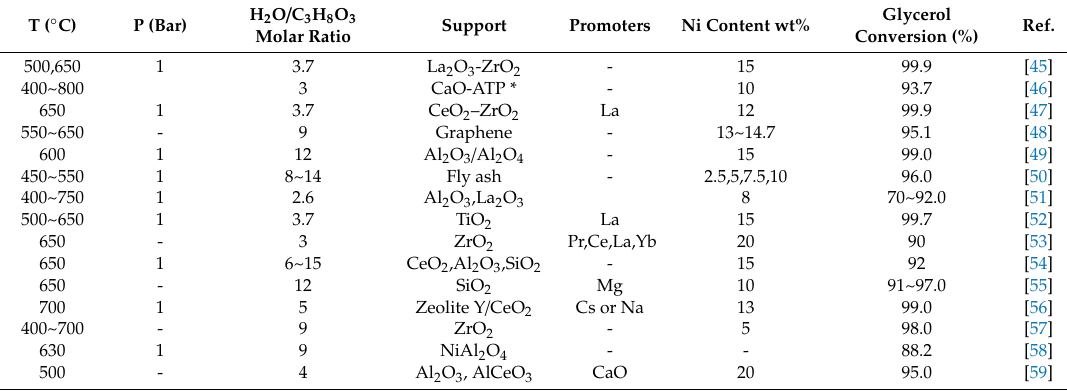
Table 1. Summary of process conditions for Ni-based glycerol steam reforming.